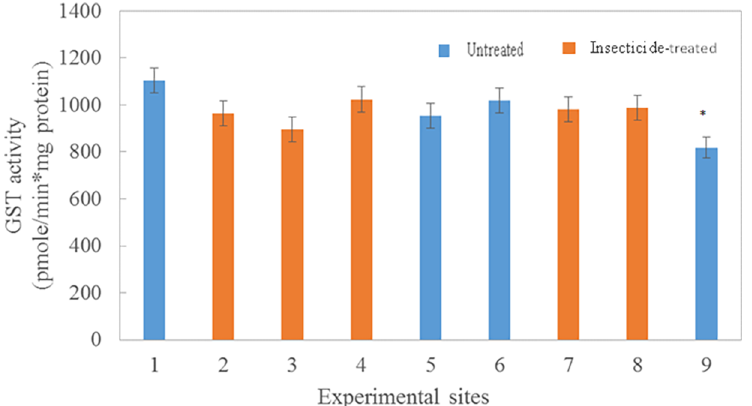
Fig 4. GST activity from bees collected during seven week period from insecticide-treated (orange bars) or– untreated (blue bars) sites. Bars represent mean activities (pmole/min (cid:3) mg protein; ± SEM) based on triplicate assays made from 10 bees collected weekly at 3 colonies from each treated or untreated site. Asterisks signify mean values that are significantly different (P < 0.05).